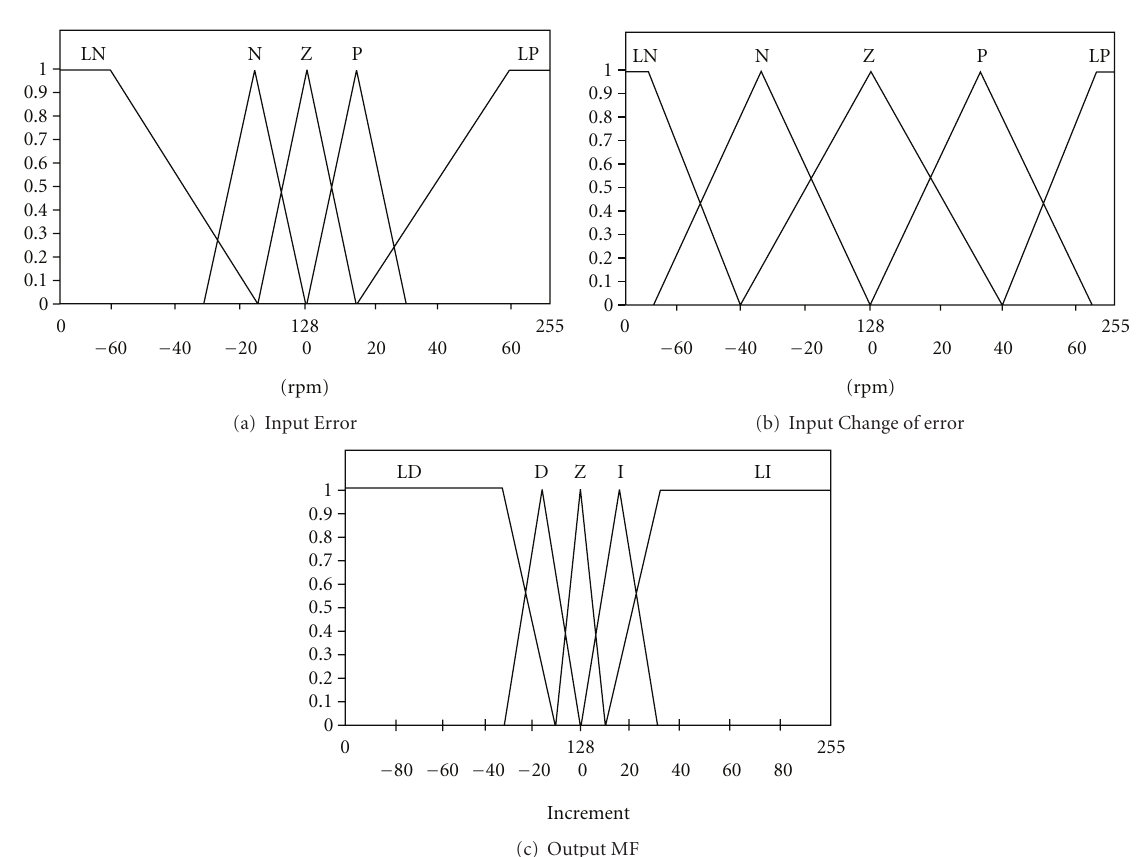
Figure 7: The FLC has two inputs: Error and Change of error, and one output. The output provides a value of increment/decrement to be use by the integral part of the PD+I controller. The first scale [0,255] are the real MFs bit values definition in the FLC. The second scale [ − 80,80] and [ − 100,100] are the operation values for this application. The scale conversion is achieved by the ARM processor.